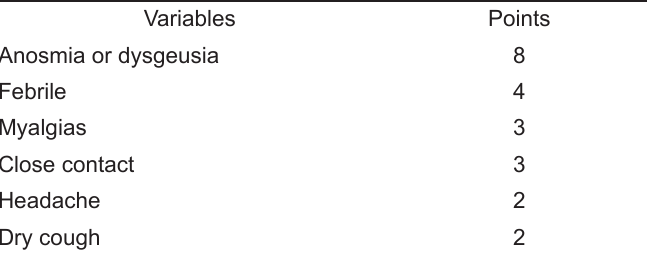
Table 4. Final scores.